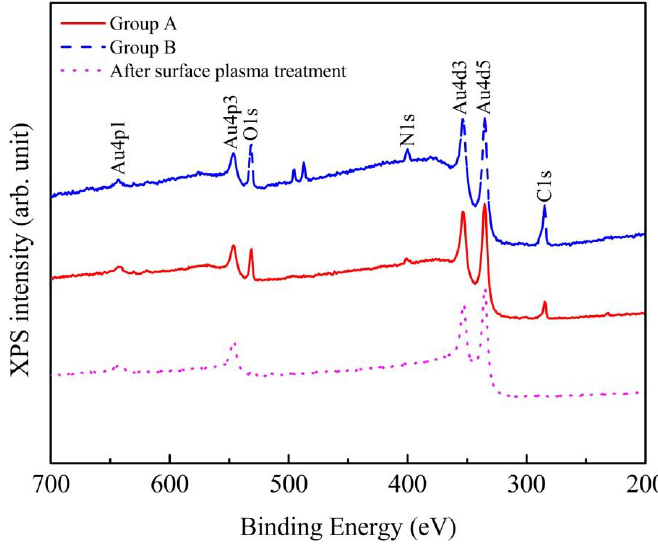
Figure 7. XPS spectra of the samples taken from Group A, Group B and after surface plasma treatment. Alien films containing O, N and C are identified for both